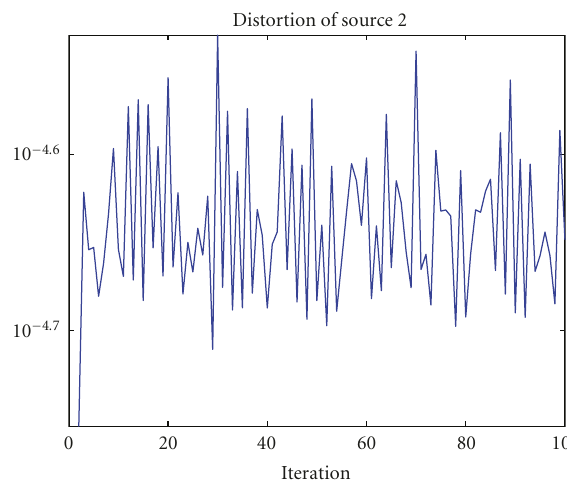
Figure 8: Distortion of source 2. Table 2: Values of the link capacities